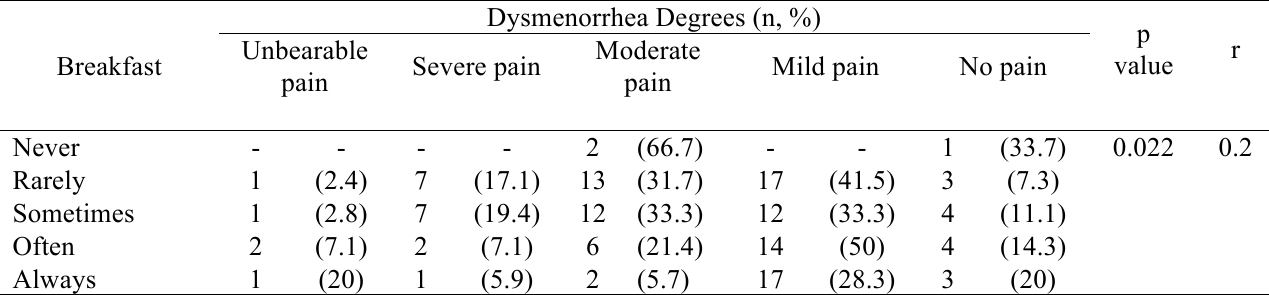
Table 4. Association between Breakfast to Degrees of Dysmenorrhea (n=132)